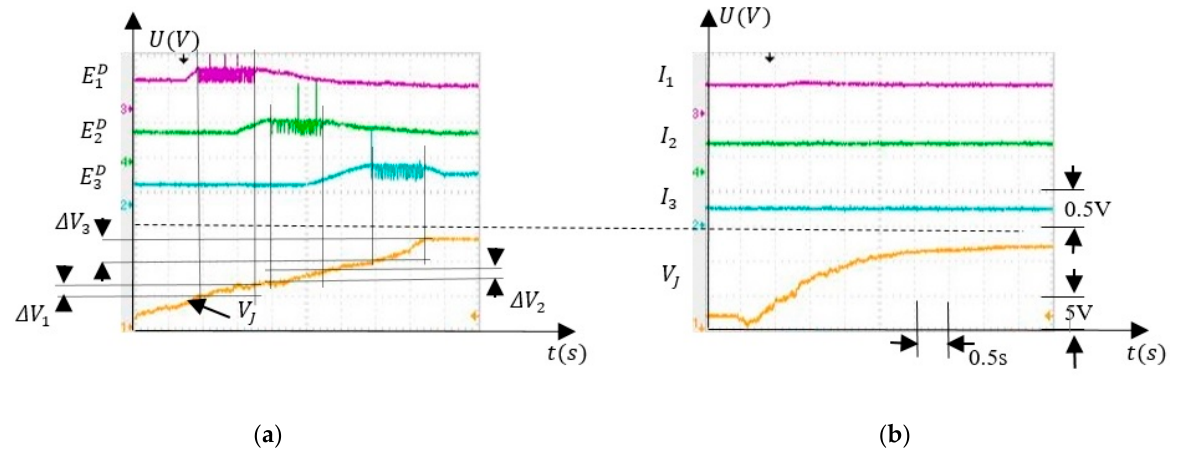
when the artificial 1 − 3